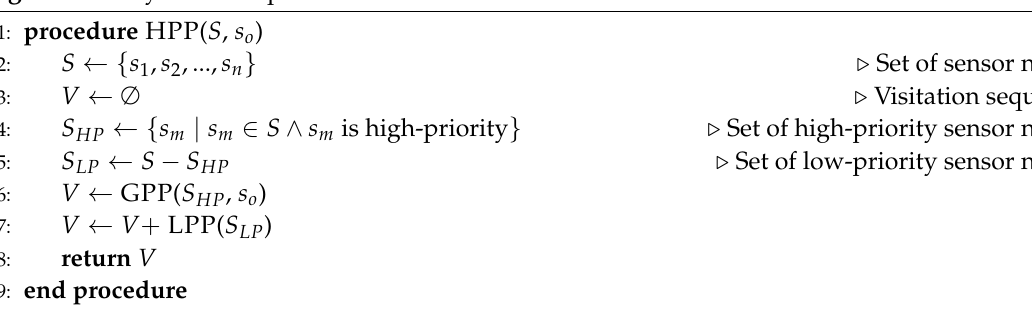
Algorithm 4 Hybrid Path planner– HPP